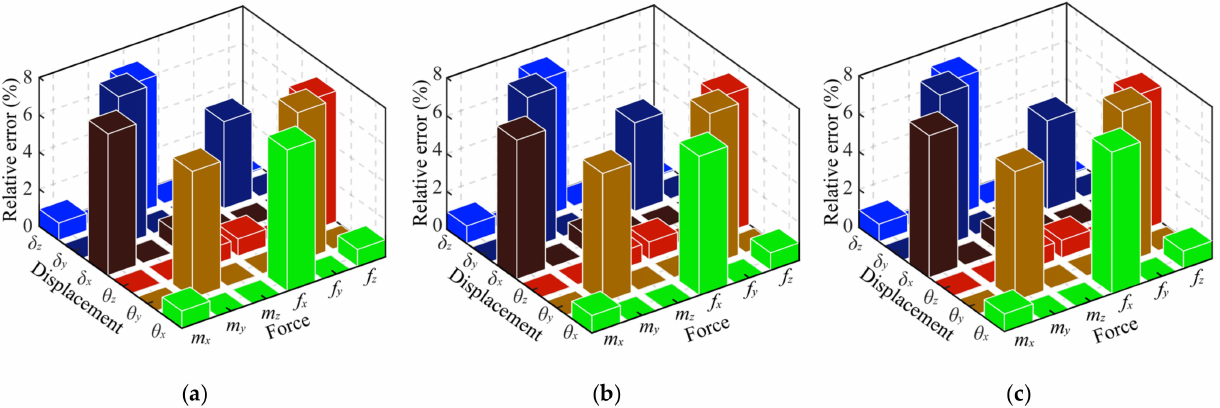
Figure A1. Relative error in percentage between analytical and FE results during the compliance model: ( a ) 3-4R; ( b ) 4-4R; ( c )